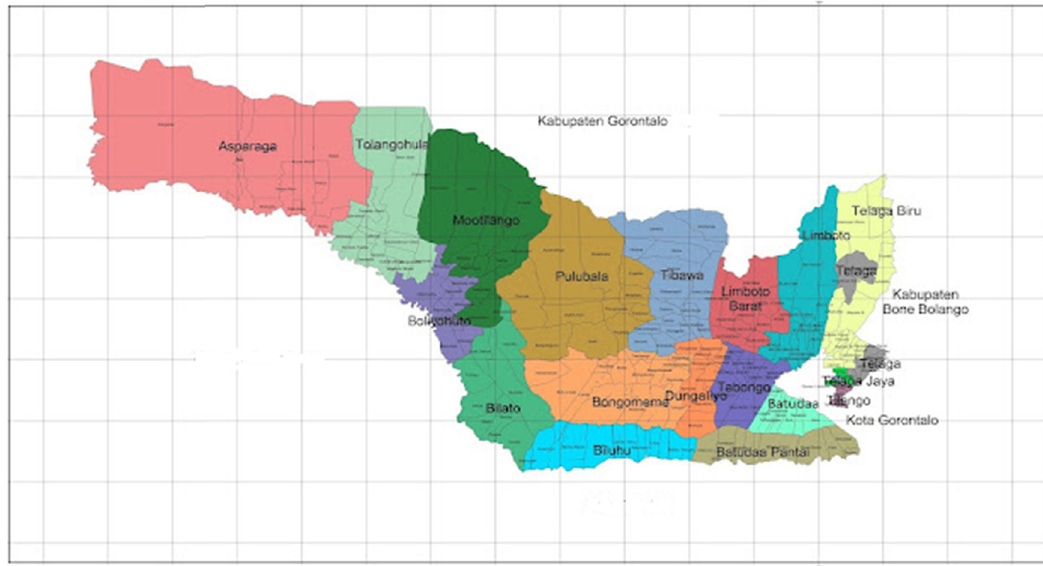
Figure 1: Research site map ( source: http://www.disdukcapil - gorontalokab.web.id )